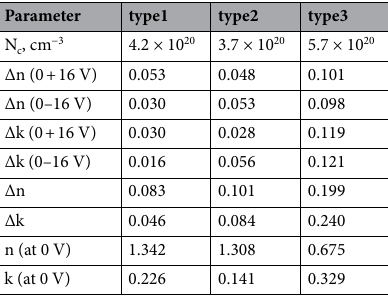
Table 2. Comparison of refractive index and extinction coefficient change for the various ITO films at λ = 1550 nm.